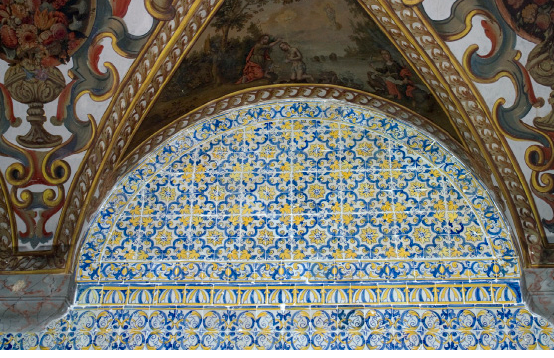
FIGURE 7 | Arches of the vaults in the lower-choir.